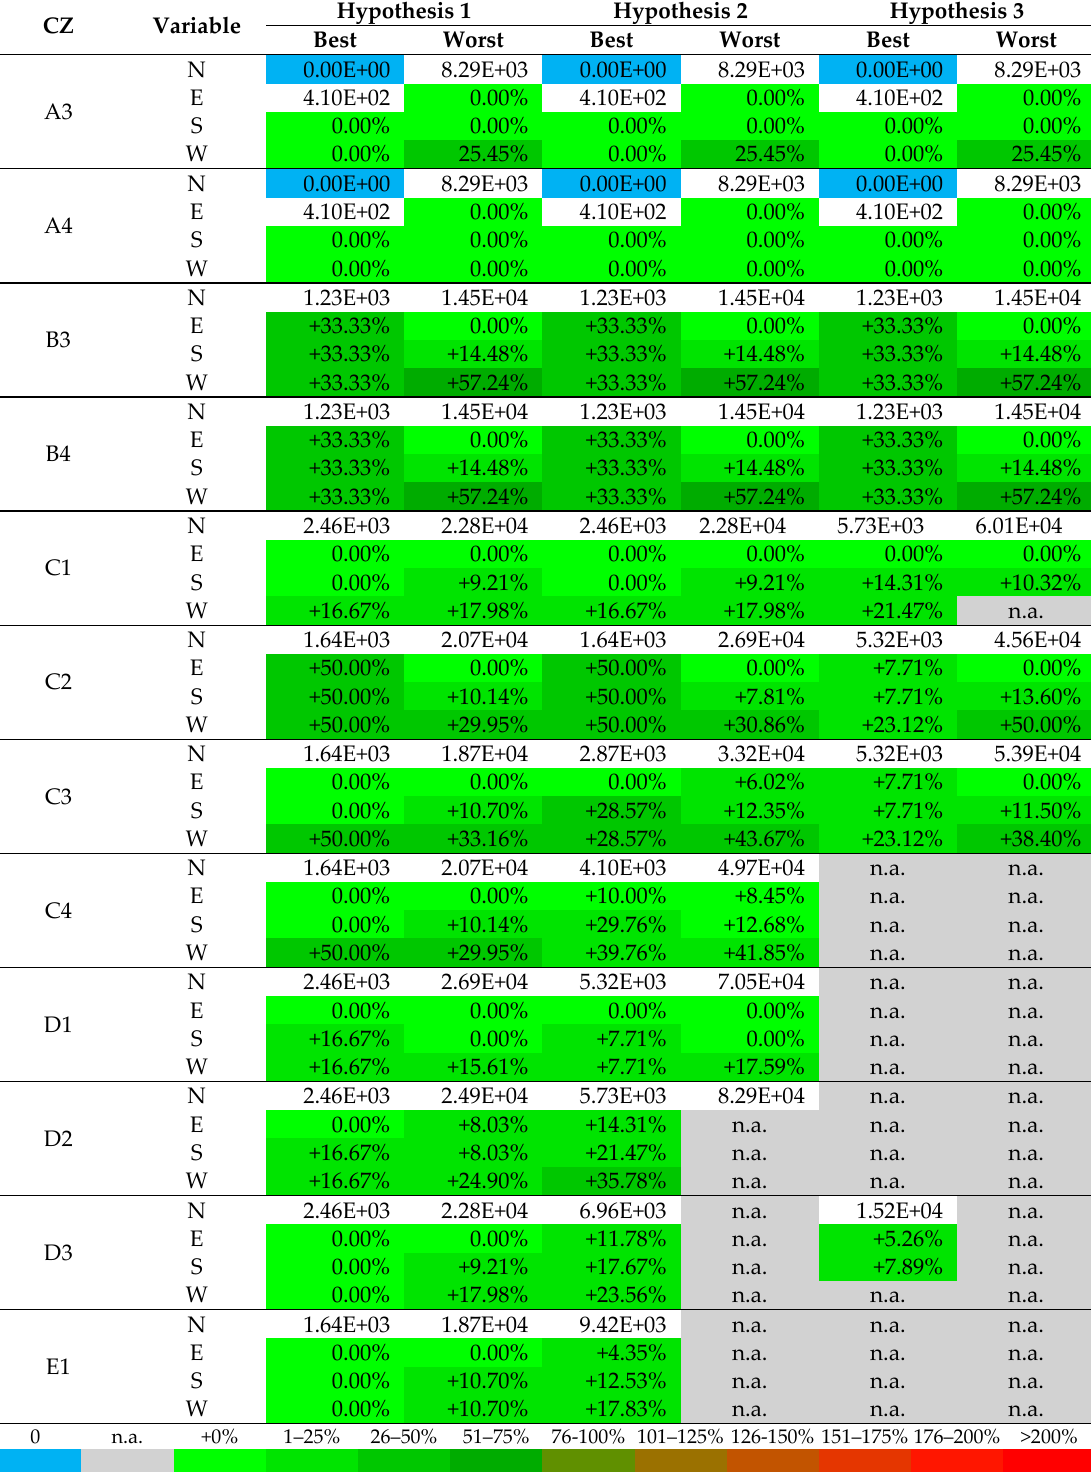
Table 8. Increase of emissions according to the orientation for the best and worst set ups.